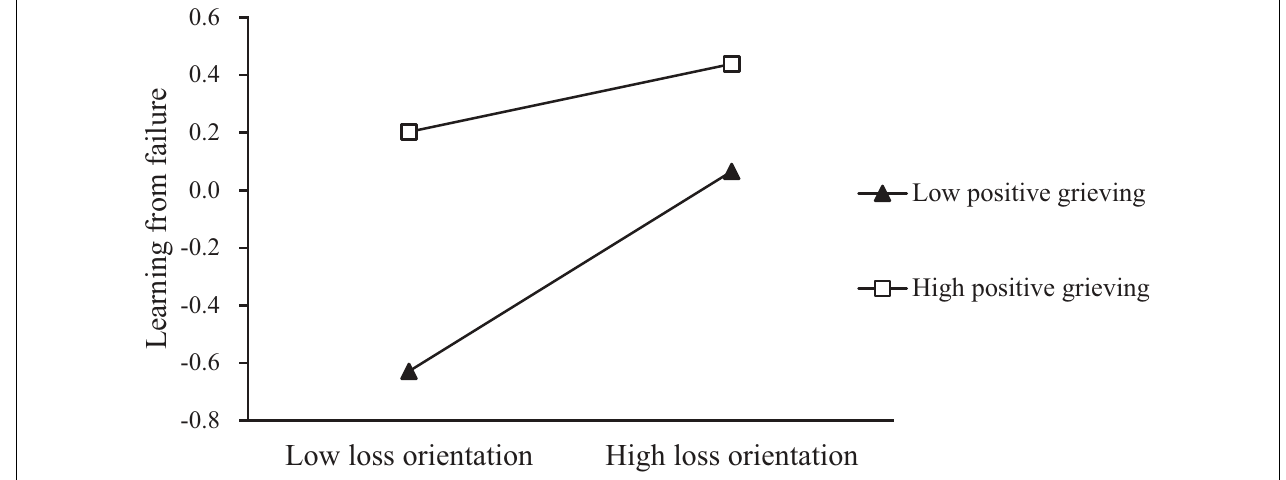
FIGURE 2 | The moderating role of Positive Grieving between Loss Orientation and Learning from Failure.